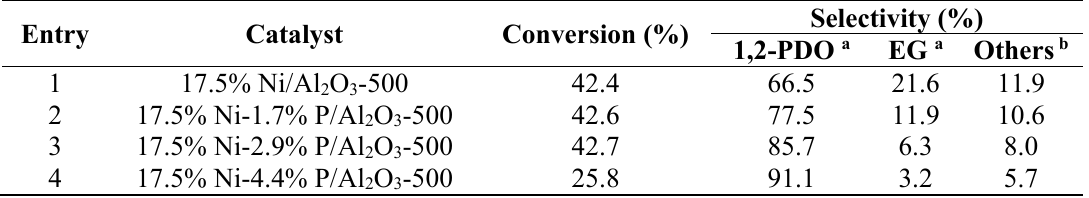
Table 1. Effect of P-doping on the catalytic performance in hydrogenolysis of glycerol. Entry Catalyst Conversion